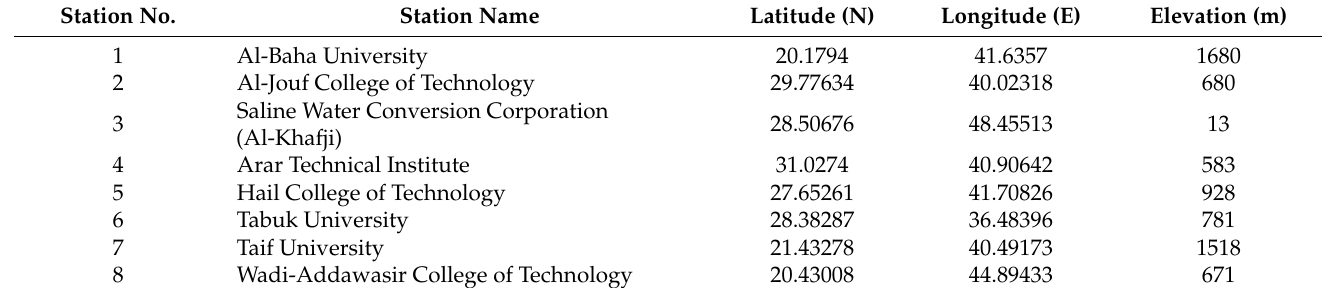
Table 2. Saudi Solar monitoring stations information.